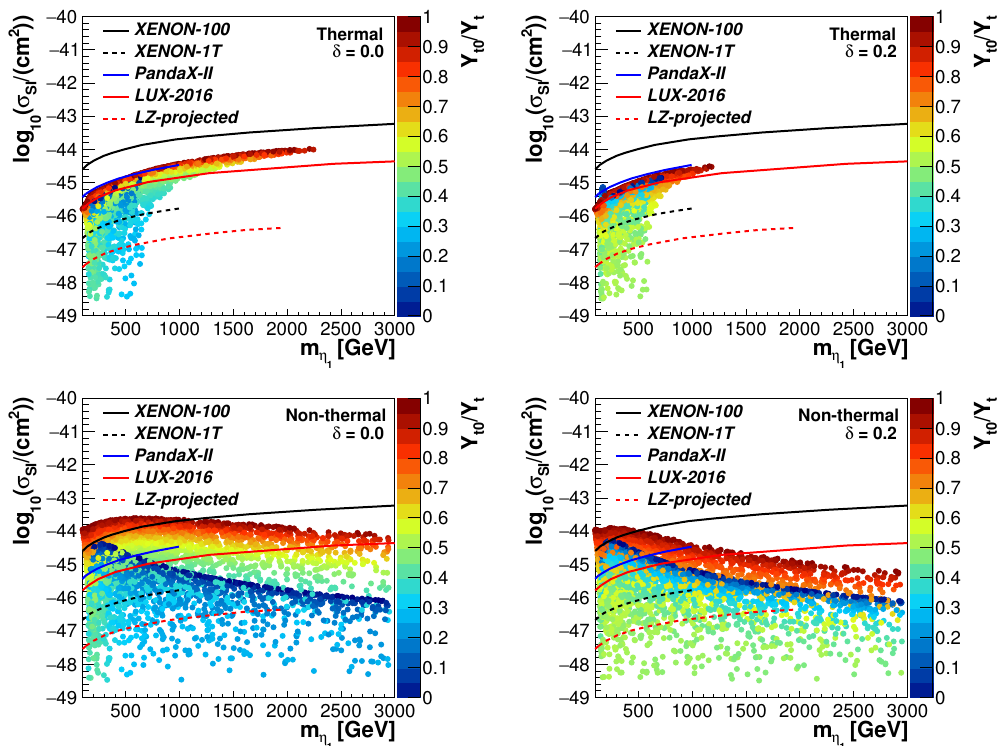
Figure 7 . Spin-independent cross section for the elastic scattering of the DM candidate (cid:17) 1 o(cid:11) nuclei compared to current and future experimental sensitivities. The upper plots show cross sections rescaled to the thermal relic abundance (overabundant points are not shown), while the lower ones assume relic abundance equal to the measured